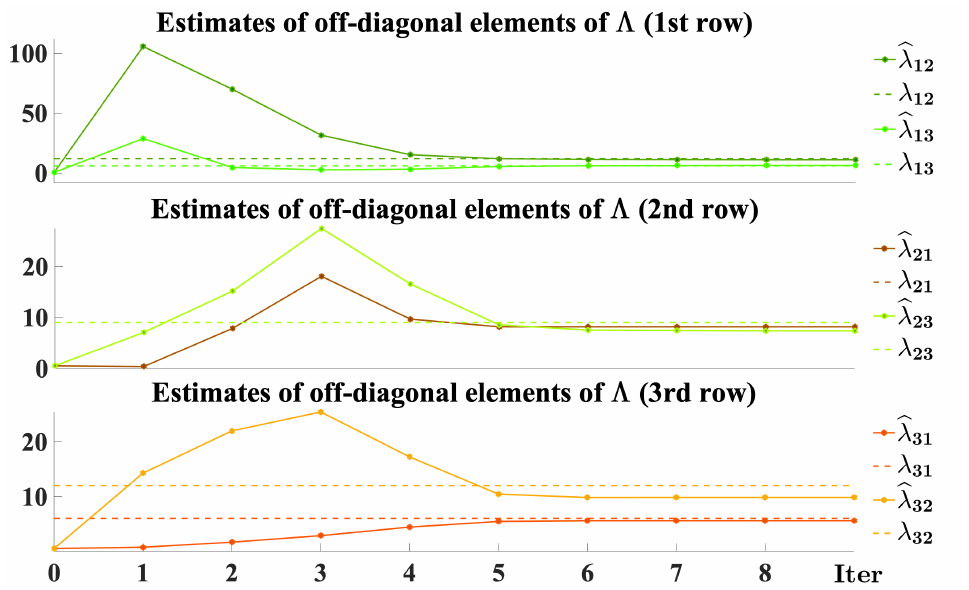
Figure 4. Estimation of the TIM Λ off-diagonal